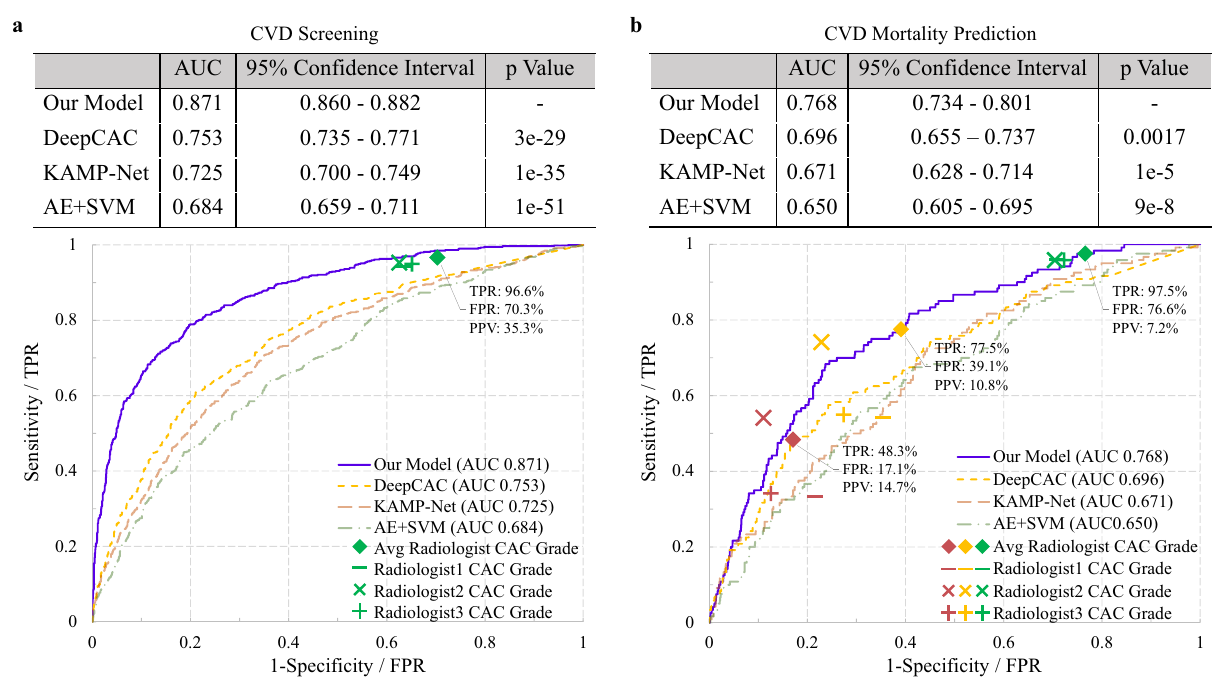
Fig. 2 Experimental results on the NLST dataset. Comparison of our model with radiologists and other reported methods on ( a ) CVD detection and ( b ) CVD-caused mortality prediction. For the reader study, green, yellow and red symbols indicate the performance of CVD risk estimation using CAC Grades 1 + , 2 + , and 3, respectively. p values were computed using a one-tail